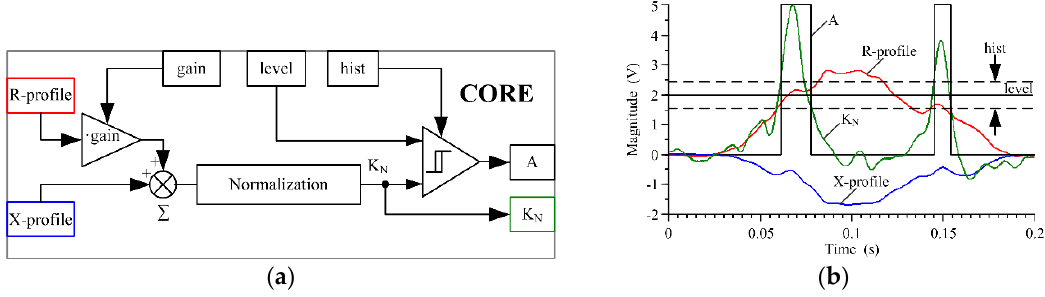
Figure 7. Algorithm-core of vehicle axle detection: ( a ) functional diagram; ( b ) example illustrating the principle of operation and signal processing, where: R and X-profile are input signals, gain, level, and hist are the setting parameters, A and K N are the output signals. Table 2. Optimal values of algorithm-core setting parameters, determined for maximum accuracy (10) of axle detection in groups considered.